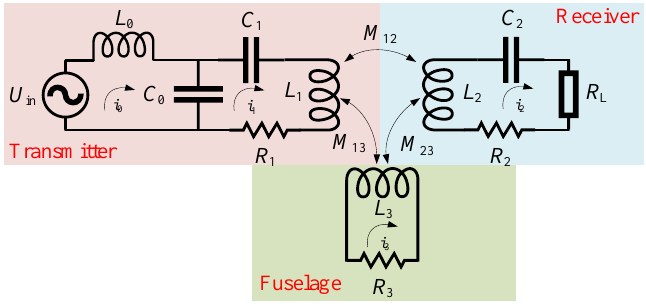
Figure 3. Equivalent circuit model.